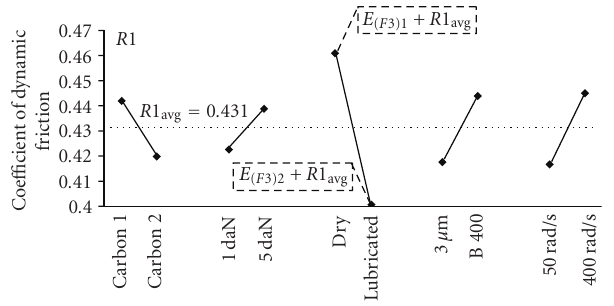
Figure 3: Main e ff ects on the coe ffi cient of dynamic friction ( R 1).